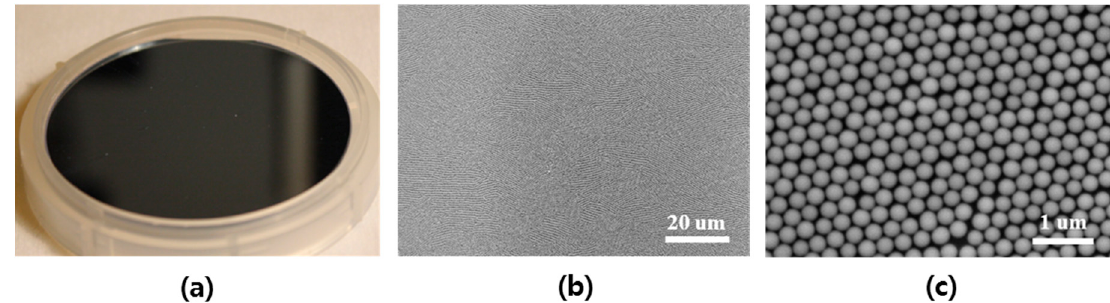
Figure 1. ( a ) Spin-coated 2-inch round Si surface, ( b ) SEM image of uniformly distributed Si nanospheres (SNSs), and ( c ) SEM image of closely-packed 2-dimensional (2-D) SNSs.